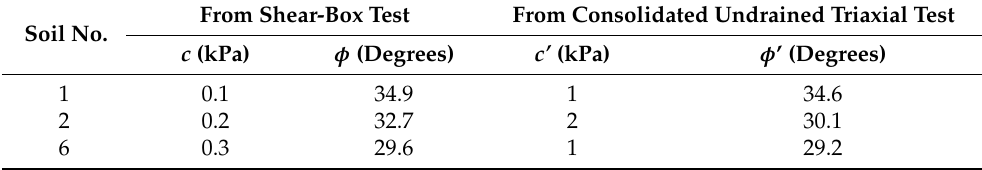
Table 2. Comparison of shear strength parameters.